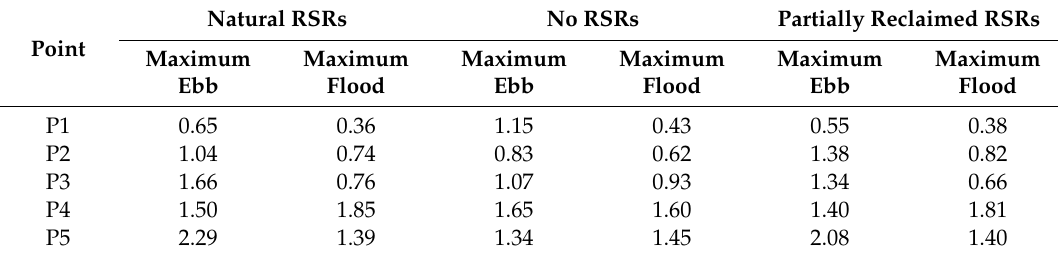
Figure 12. The position of the flow rate analysis points. Table 5. Flow rate change value (m/s).